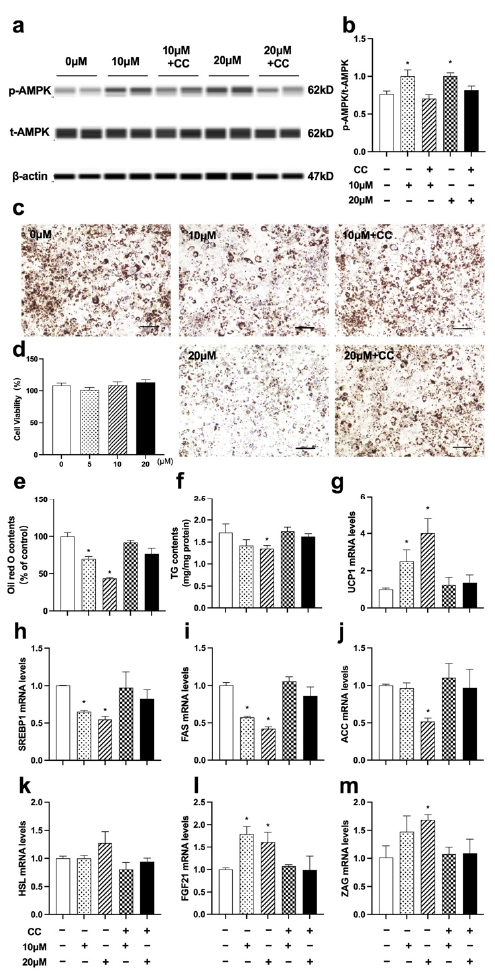
Figure 8. Nuci inhibited lipid accumulation by activating AMPK phosphorylation in fully differentiated 3T3-L1 adipocytes. 3T3-L1 preadipocytes were cultured and induced differentiation, then fully differentiated adipocytes were treated as described in the Method 2.9. The protein levels of p-AMPK, t-AMPK, and β -actin were analyzed by Simple western ( a ), the expression of p-AMPK was normalized against t-AMPK ( b ). Oil red O staining was conducted and photographed at 100× magnification ( c ) and Oil red O dye was extracted and detected ( e ). Cell viability after treatment of 0~20 μ M Nuci were determined by CCK-8 ( d ). Intracellular TG contents ( f ) were determined by a commercial kit following the manufacturer’s instructions. The mRNA expressions of UCP1 ( g ), SREBP1 ( h ), FAS ( i ), ACC ( j ), HSL ( k ), FGF21 ( l ), and ZAG ( m ) were determined by RT-qPCR. Data were presented with mean ± SE from three independent experiments, * p < 0.05 vs. the control group (0 μ M).